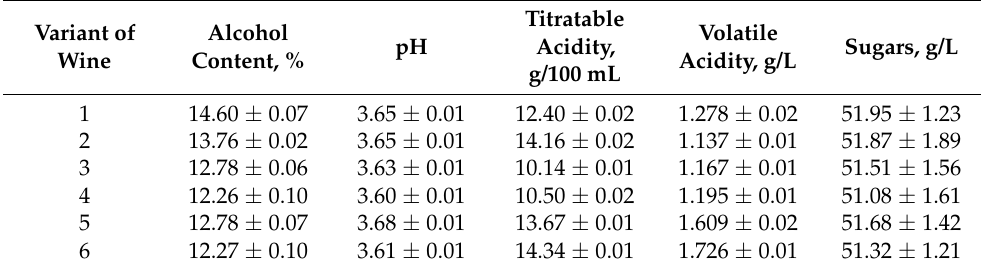
Table 1. Mean and standard deviation of physicochemical parameters in different variants of wine prepared from fruits of Rosa rugosa